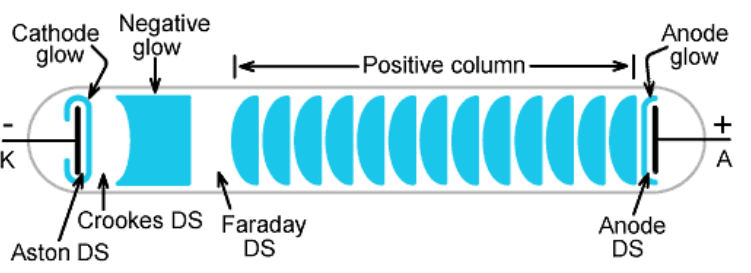
Figure 3. Schematic of DC glow discharge showing several distinct regions that appear between cathode and